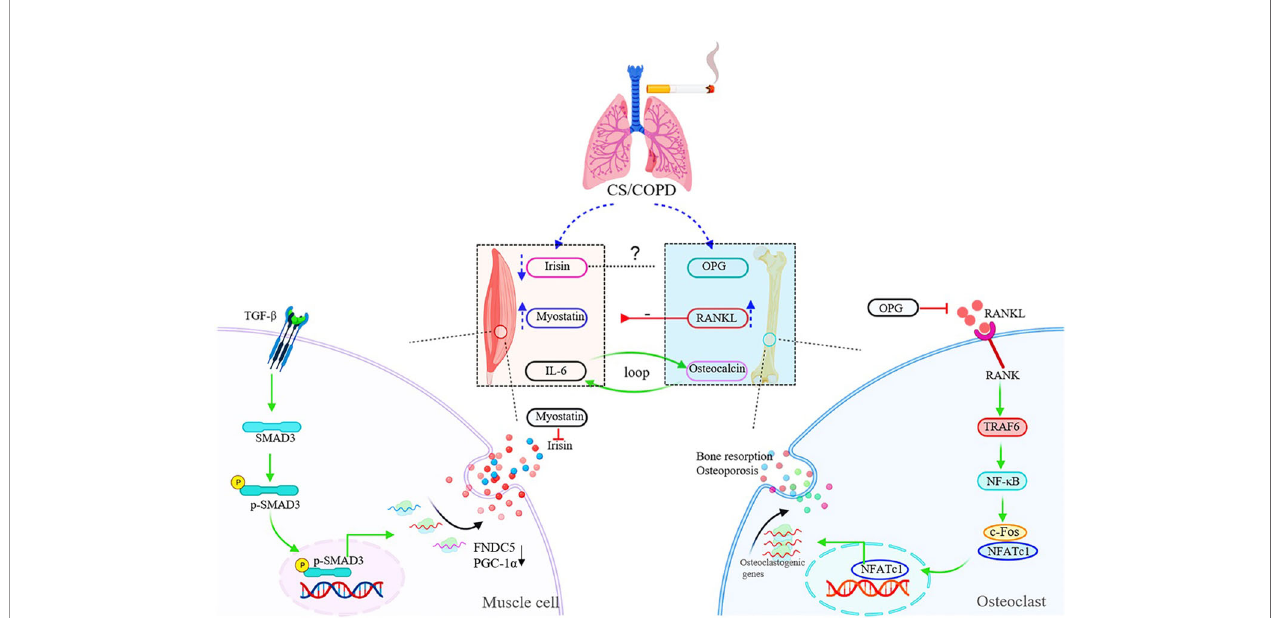
FIGURE 2 | Schematic diagram of muscle-bone crosstalk in COPD. In COPD, the serum levels of irisin are decreased, while myostatin and RANKL are up-regulated in both circulation and skeletal muscles. The raised expression of RANKL induced by chronic cigarette smoke exposure contributes to muscle atrophy/skeletal muscle dysfunction through the RANKL/RANK pathway. The fi gure also shows the speci fi c signaling pathway of irisin and RANKL. TGF- b binds to TGF- b R1/TGF- b R2 complex, and Smad3 is phosphorylated and translocated into the nucleus to bind the promoters of PGC-1 a and FNDC5 to suppress their transcription, and suppression of FNDC5 transcription and protein leads to decrease in circulating irisin in vitro . RANKL activates the homologous receptor RANK on the surface of osteoclasts and osteoclast precursors, and activated RANK causes the recruitment of the adapter protein TRAF6, leading to NF- k B activation and translation of NF- k B to the nucleus. NF- k B increases the expression of c-Fos, and c-Fos interacts with NFATc1 to trigger the transcription of osteoclastogenic